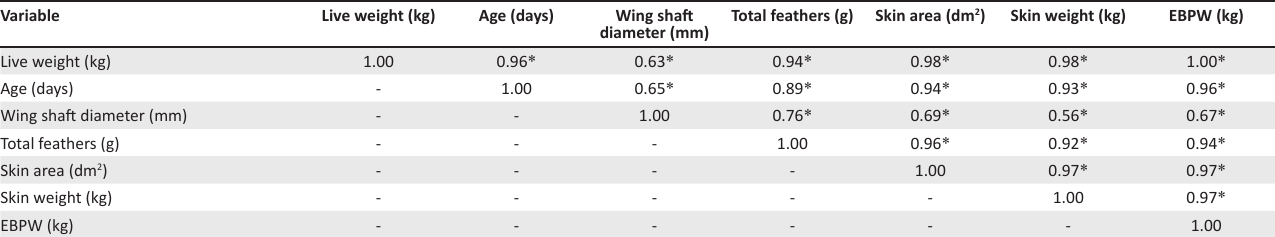
TABLE 6: Correlation coefficients ( r ) between a range of explanatory variables related to a model to predict feather and skin development in ostriches. Variable